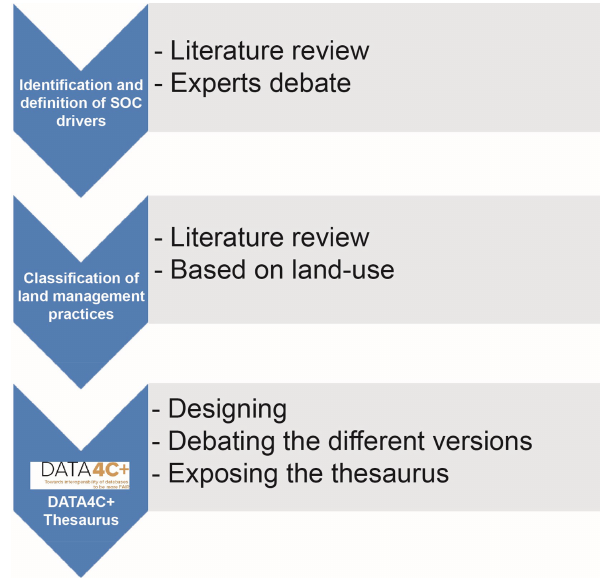
Figure 1. Summary of the different steps to build the DATA4C +